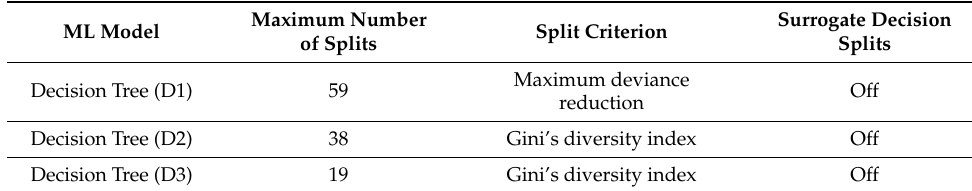
Table A1. Decision Tree: optimized hyperparameters for each dataset.